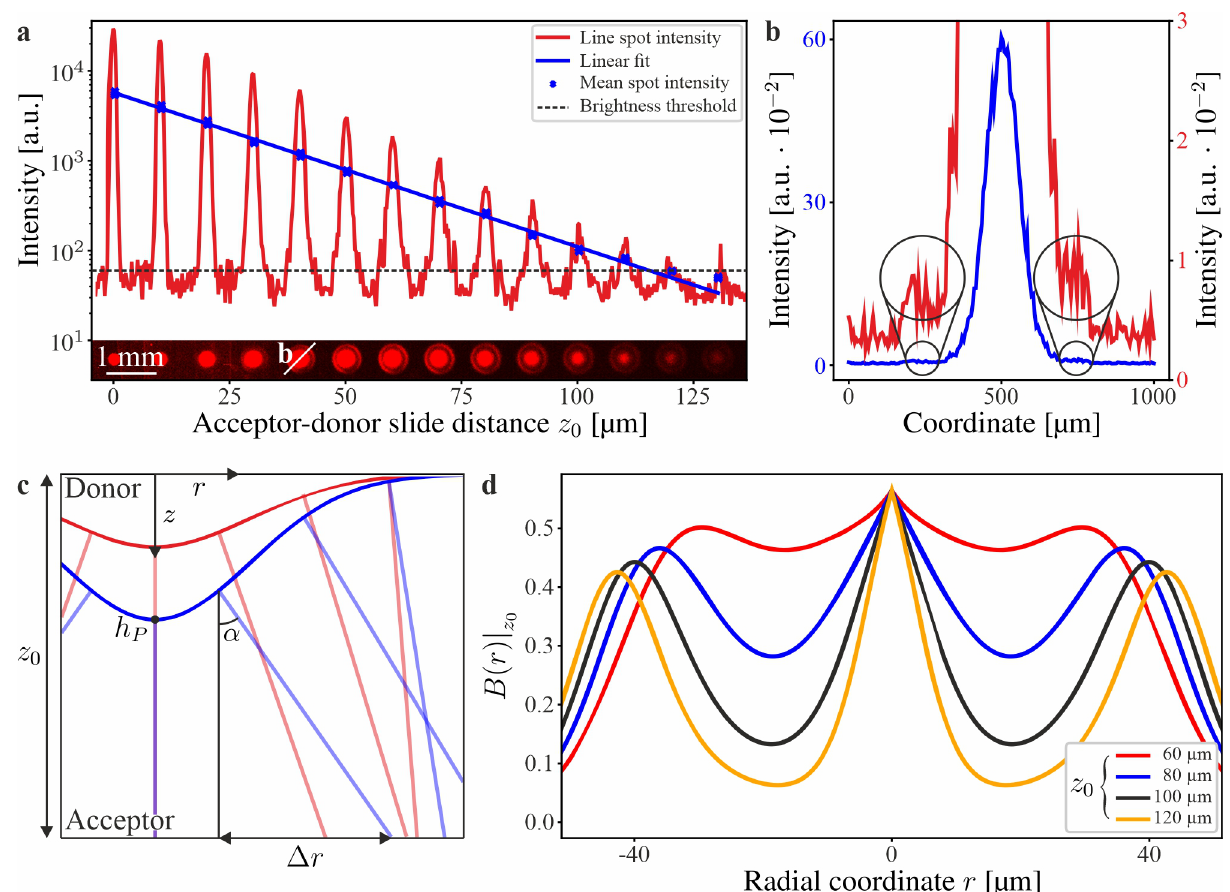
Figure 3. Ejection-based material deposition: Material deposition from a Rhodamine 150 donor substrate with 160mW and 10ms lasing power and duration over an acceptor–donor substrate distance of up to 130µm ( a ). These depositions show an exponential decrease in the fluorescence mean and line spot intensity with an increasing distance between acceptor and donor substrates. Specifically, a decrease from ≈ 6 · 10 3 [a.u.] to ≈ 5 · 10 1 [a.u.] and from ≈ 2.8 · 10 4 [a.u.] to ≈ 7 · 10 1 [a.u.] for the mean and peak spot intensity is observed. In addition, a 1.5–2 magnitudes weaker ring structure is observed ( b ), which increases its radius with an increasing acceptor–donor substrate distance. Finally, the assumed ejection in normal direction of the donor substrate polyimide expansion over a distance z 0 toward the acceptor substrate for two time points (( c ); red and blue) and the qualitative shape function B ( r ) | for different z 0 is shown (( d ); T = 10ms, P = 160mW, and ω = z 0